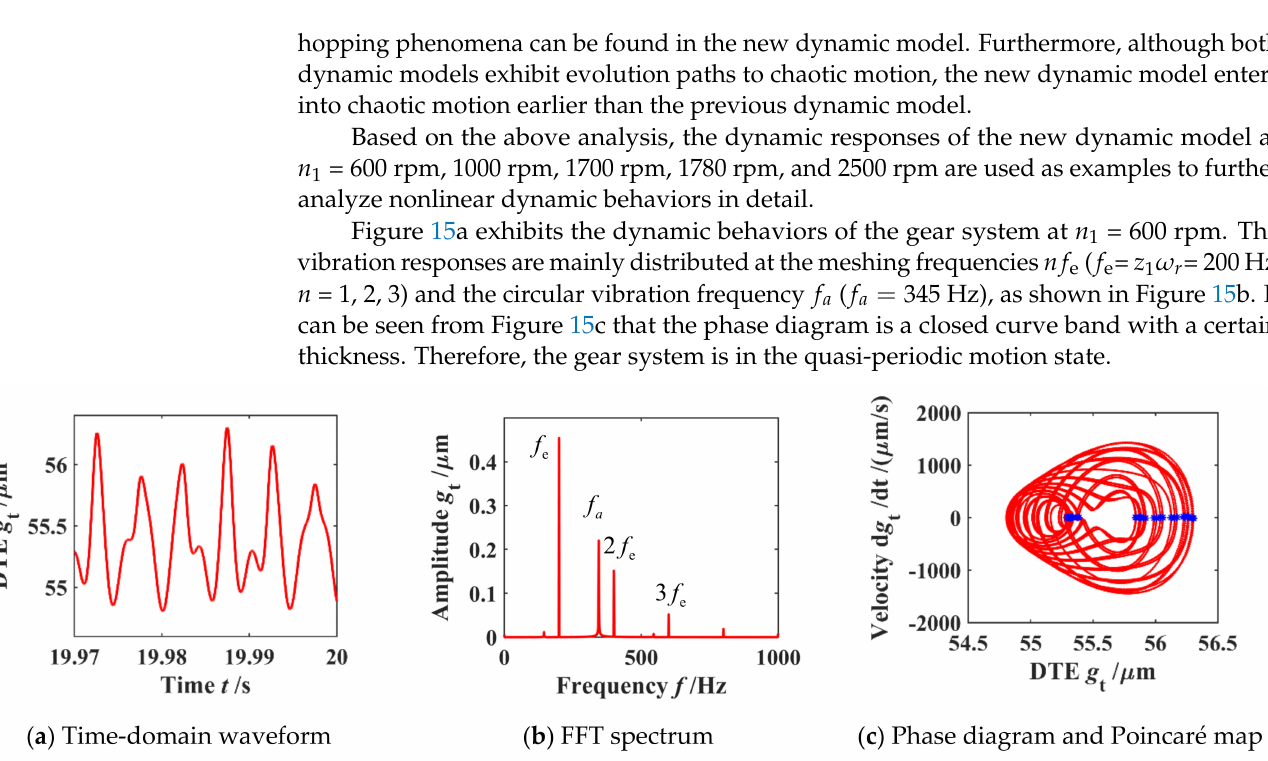
Figure 15. Dynamic responses at n 1 = 600 rpm.